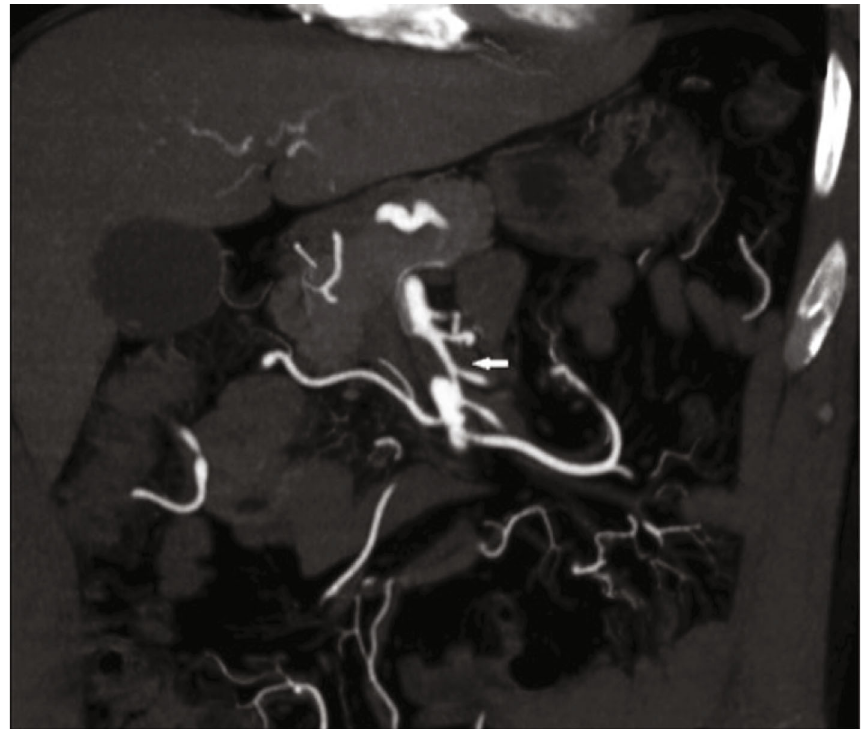
Figure 1: Dissection of the superior mesenteric artery (arrow).